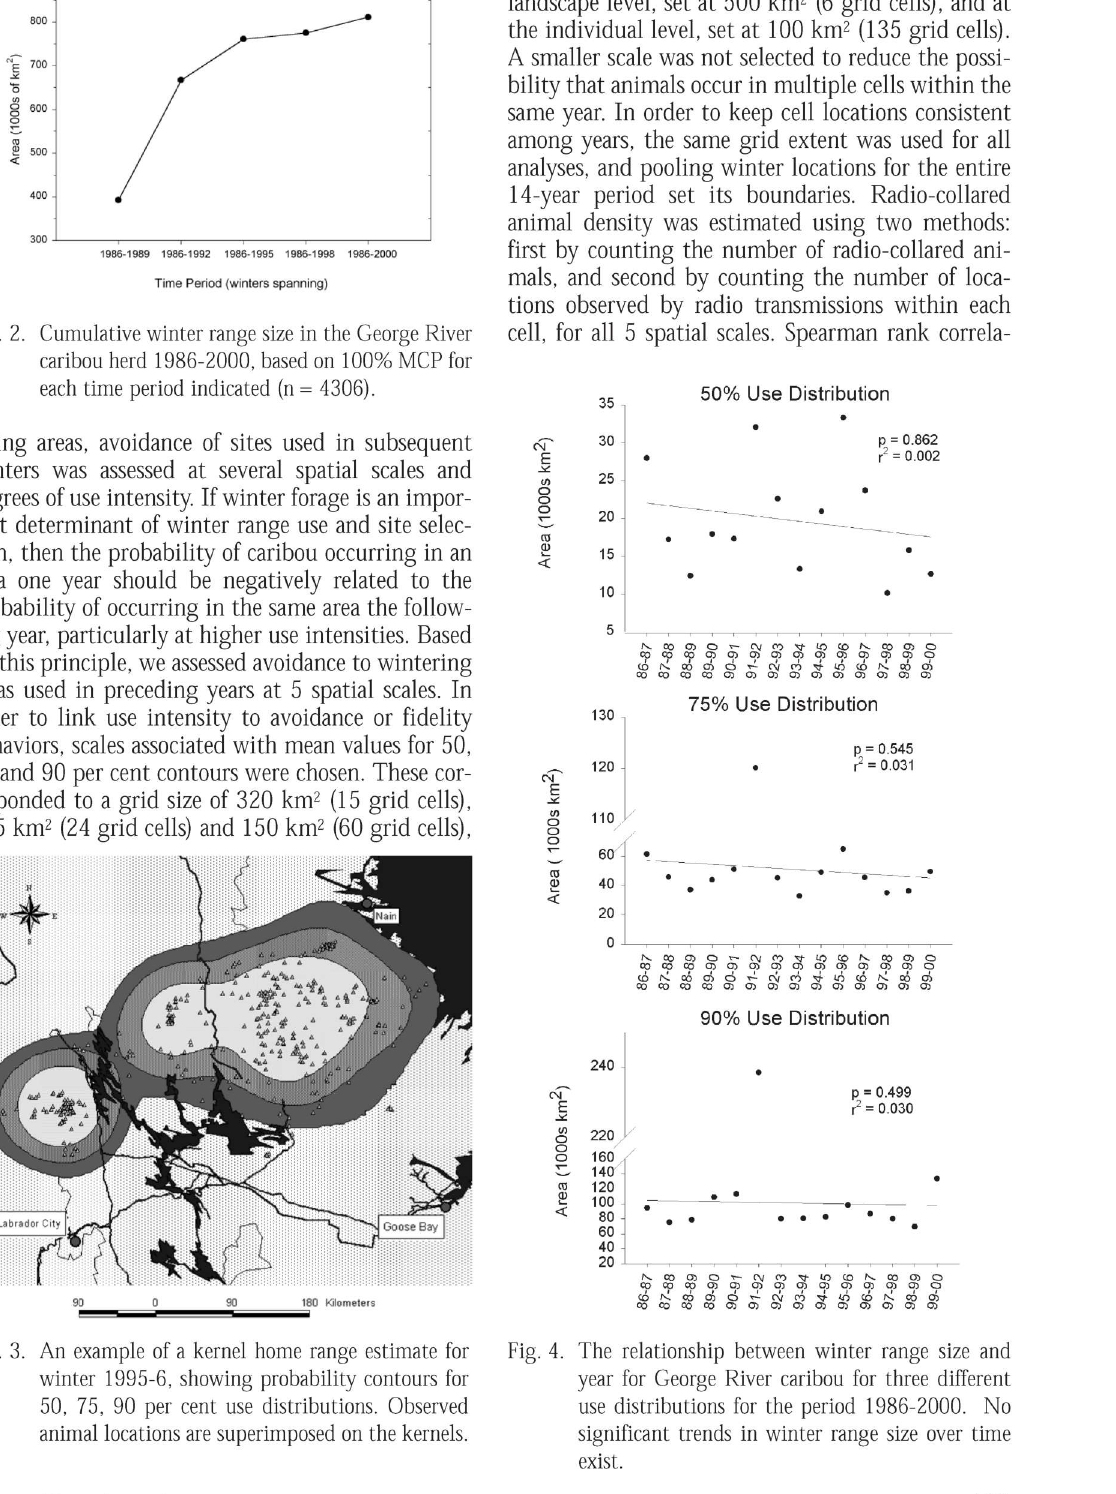
Fig. 3. An example of a kernel home range estimate for winter 1995-6, showing probability contours for 50, 75, 90 per cent use distributions. Observed animal locations are superimposed on the kernels.